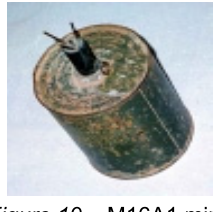
Figure 19 – M16A1 mine Рис . 19 – Мина M16A1 Слика 19 – Мина M16A1